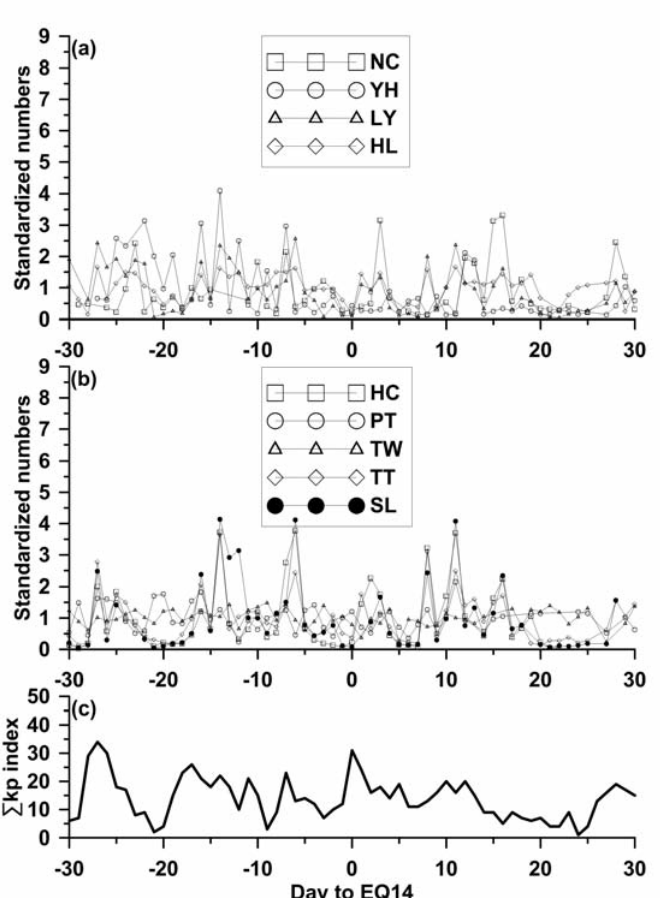
Figure 3. The standardized numbers and the R kp index 30 days before and 30 days after EQ14. (a) Standardized numbers at NC, YH, LY and HL. (b) Standardized numbers at HC, PT, TW, TT and SL. (c) Variations un the R kp